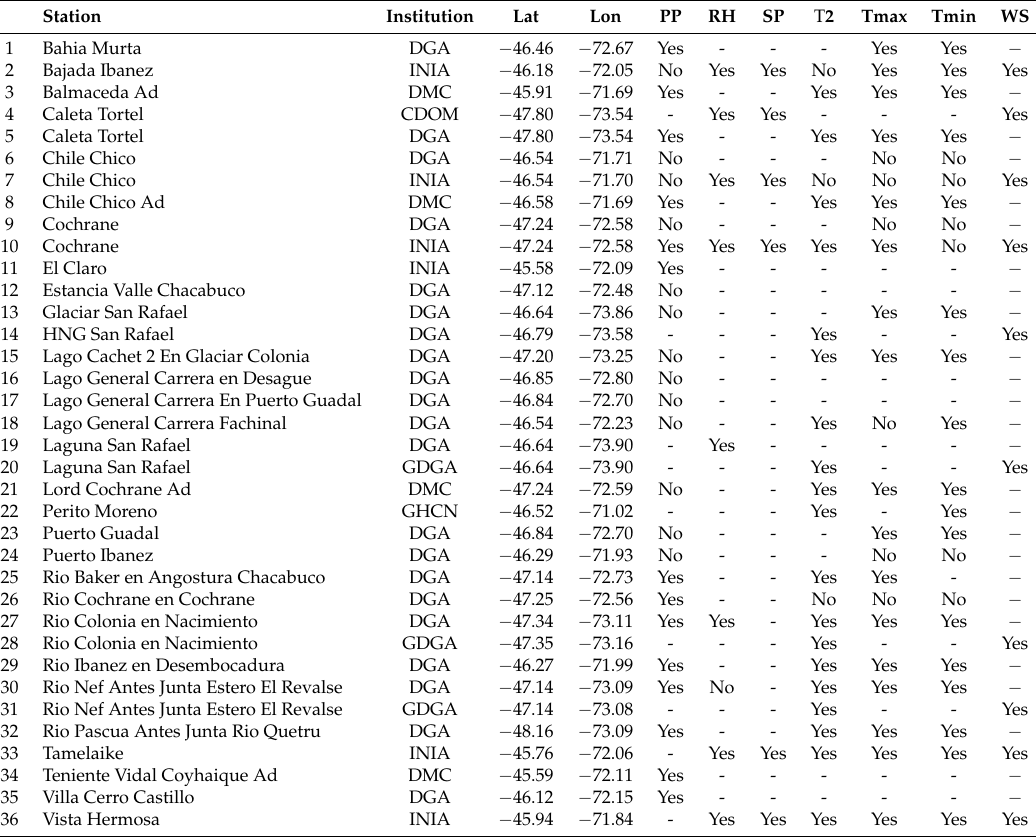
Table 1. Meteorological stations available in the study area from public institutions. A distinction was made between used (Yes) and unused (No) stations, and variables not measured (-) by the station. The variables are precipitation (PP), relative humidity (RH), surface pressure (SP), mean air temperature (T2), maximum temperature (Tmax), minimum temperature (Tmin), and wind speed (WS).